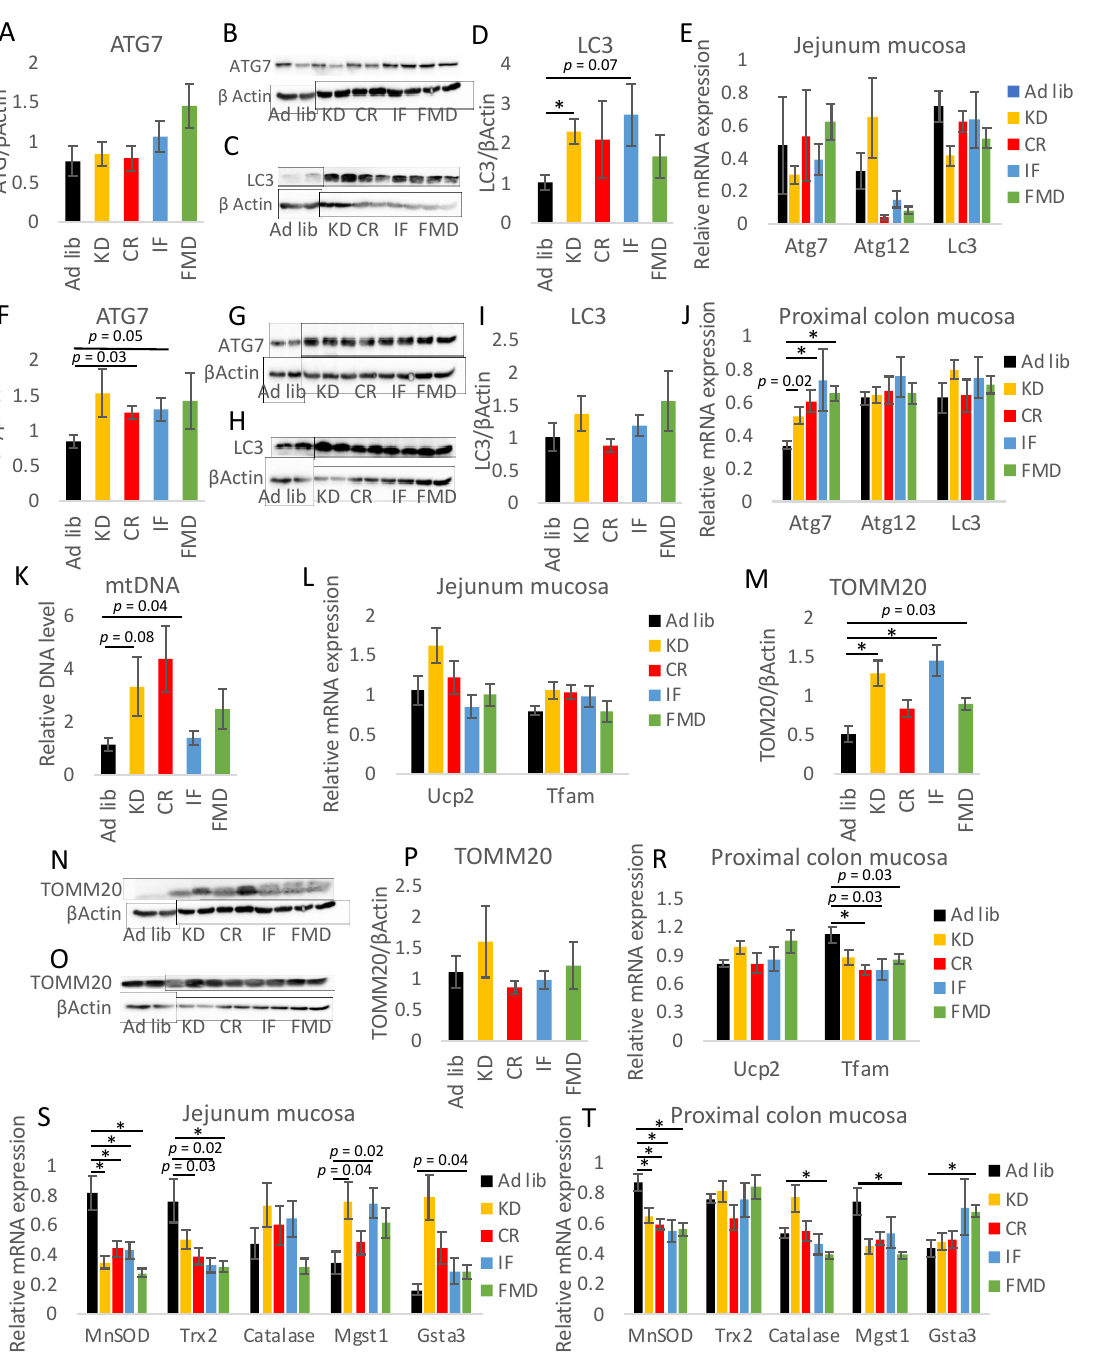
Figure 7. Restrictive diets affect the expression of autophagy- and mitochondria-related factors. Pro- tein levels of ATG7 ( A , B , F , G ) and LC3 ( C , D , H , I ) were measured in the mucosa of the jejunum ( A – D ) and proximal colon ( F – I ). Gene mRNA expression of Atg7, Atg12, and Lc3 was measured in the